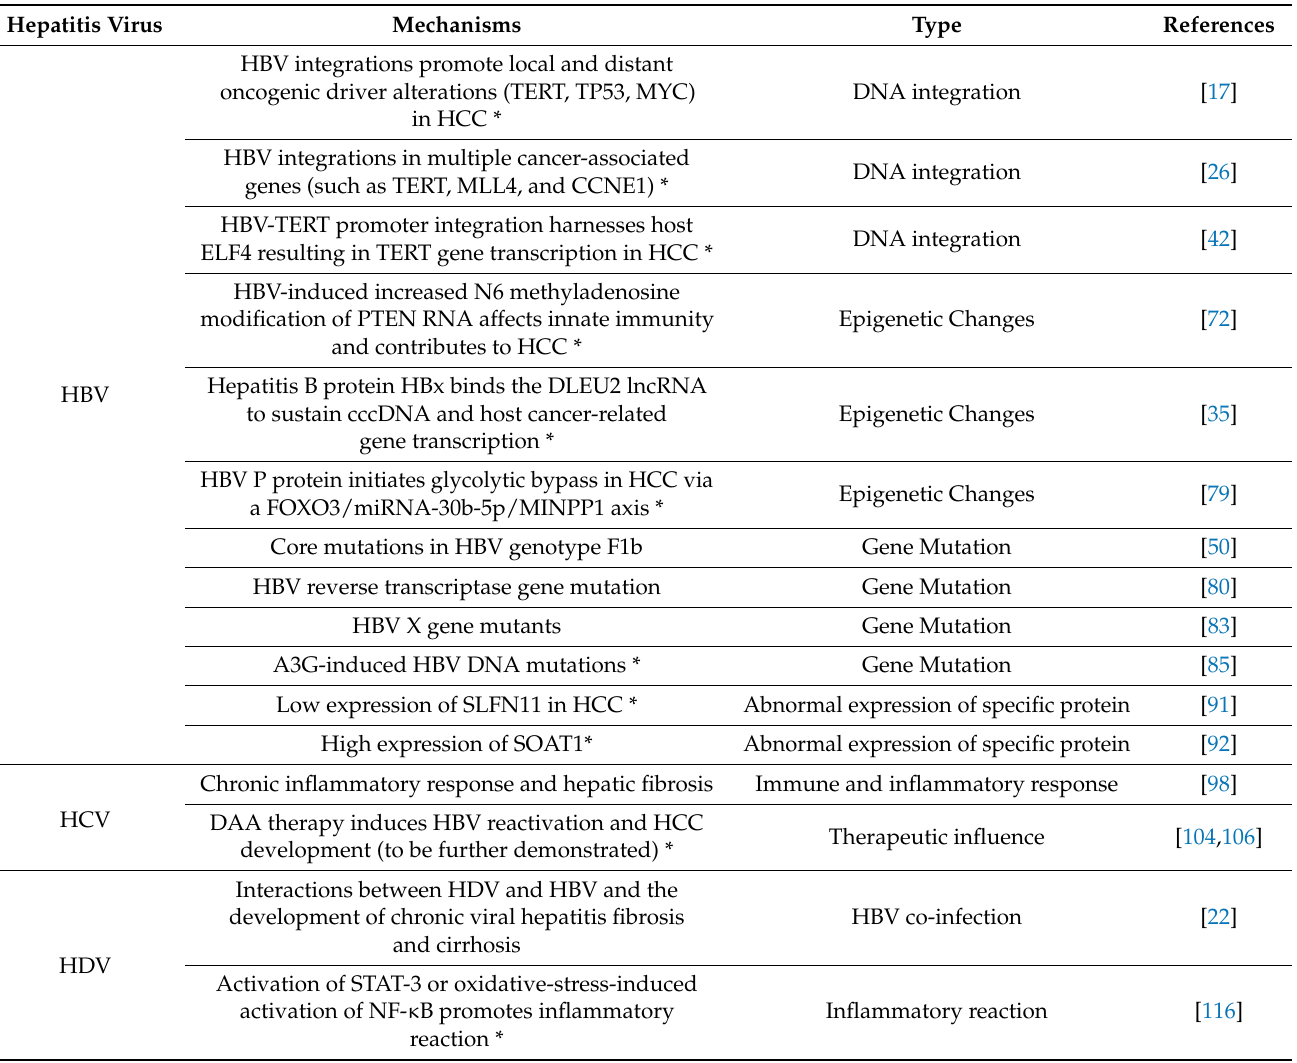
Table 1. Overview of the mechanisms of hepatitis virus induction into